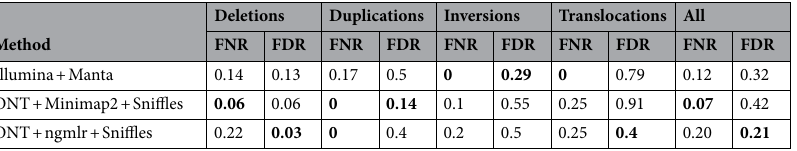
Table 2. Estimates of false negative rates (FNR) and false discovery rates (FDR) for different structural variant calling methods. Bold numbers highlight the lowest values in each